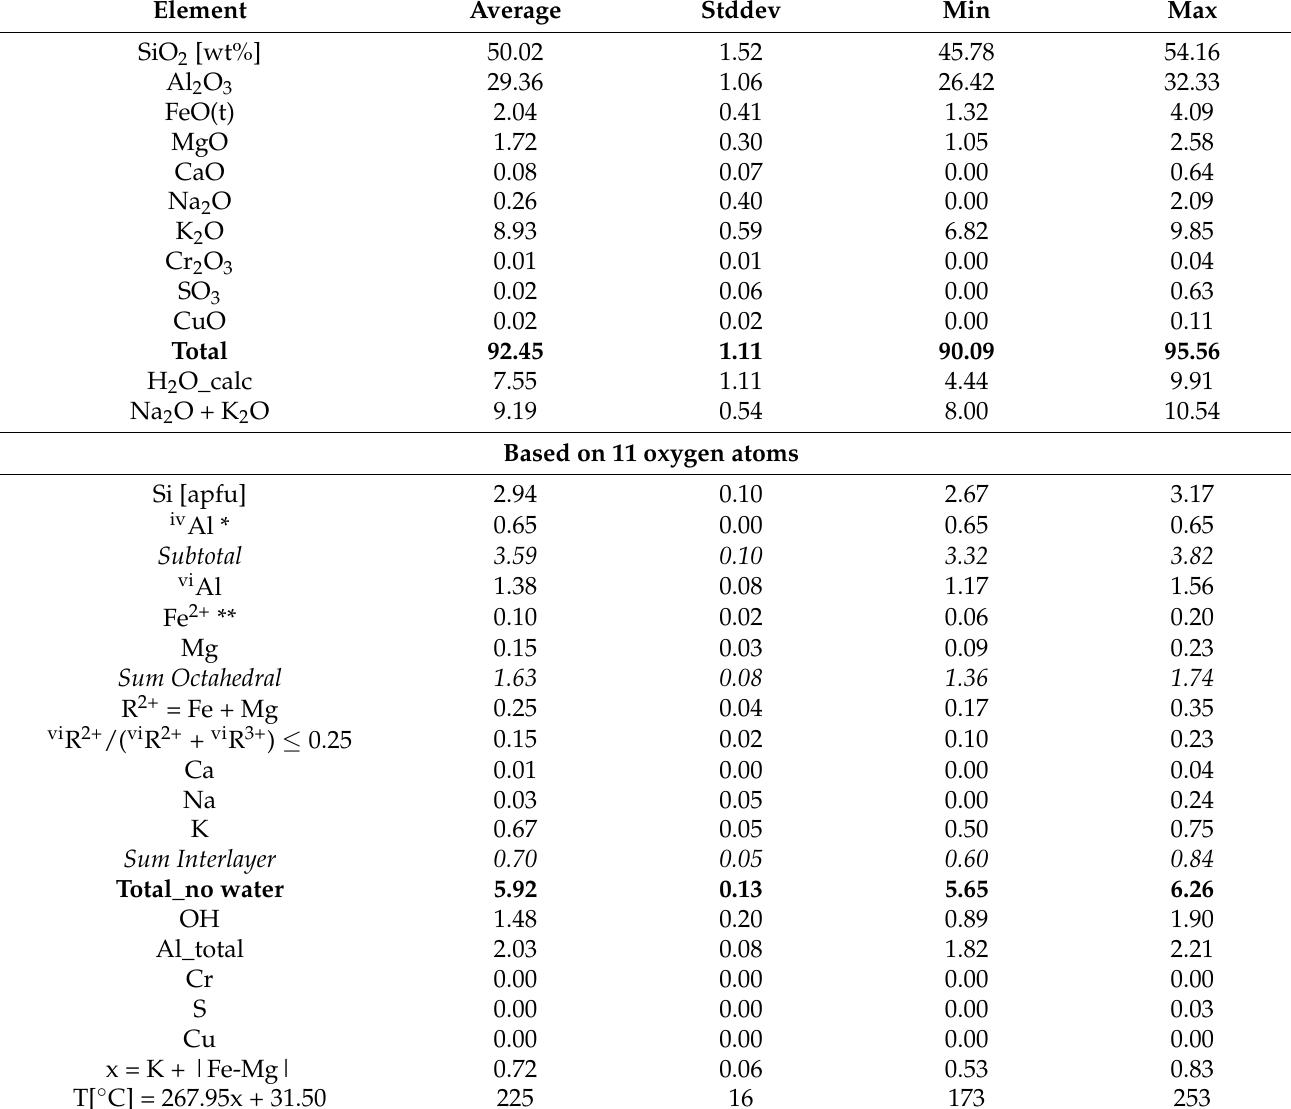
Table 3. Summary of illite (n = 102) composition analyzed via EMPA in felsic volcanic rocks. Temperature calculation